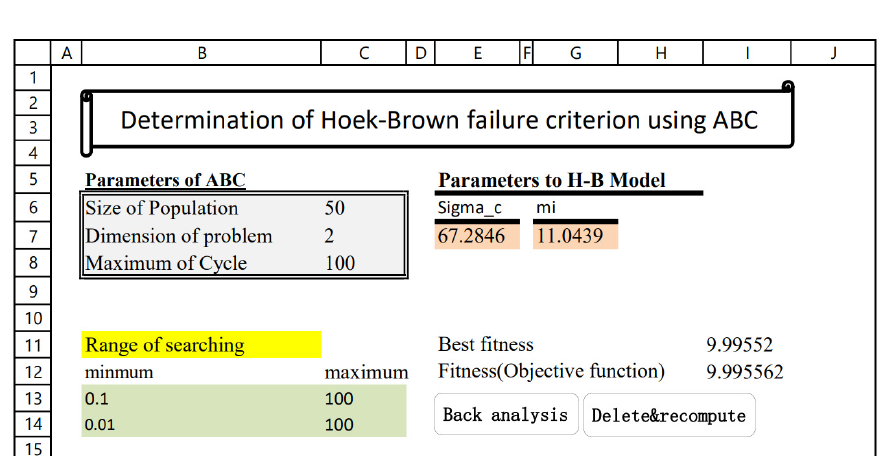
Figure 5. The determination of the Hoek-Brown failure criterion using ABC.